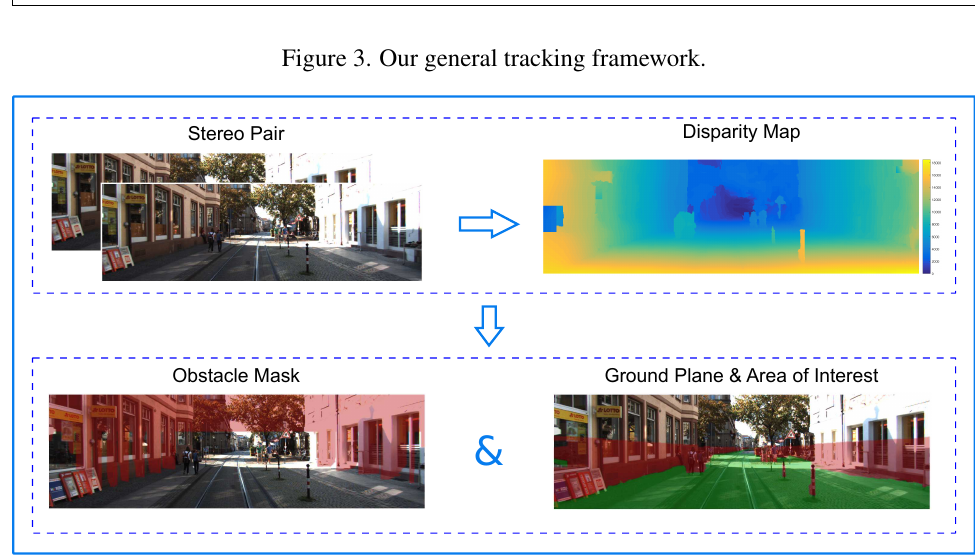
Figure 4. Scene modeling. Using stereo information, we generate three different areas in the image space including obstacle, ground plane and area of interest.